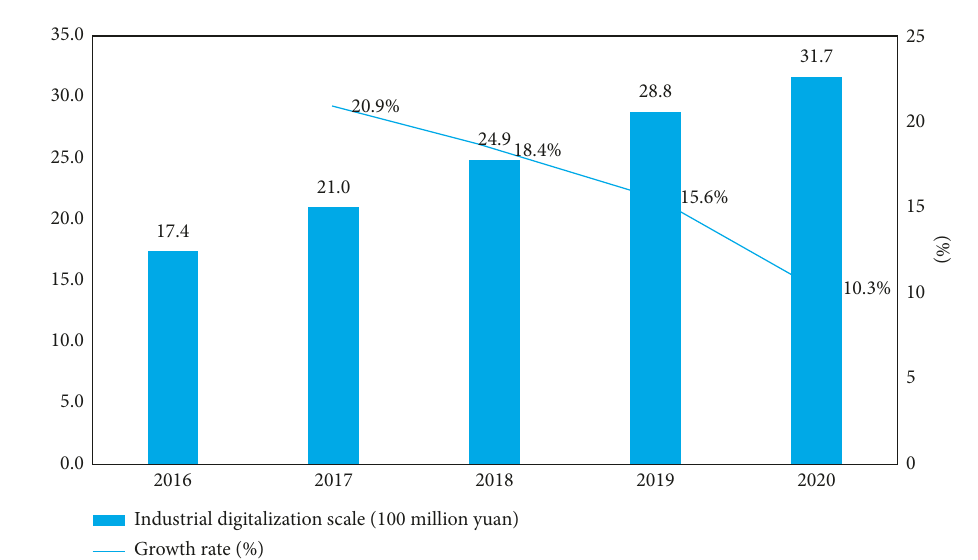
Figure 2: Scale and growth rate of industrial digitalization from 2016 to 2020 (unit: trillion yuan, %).